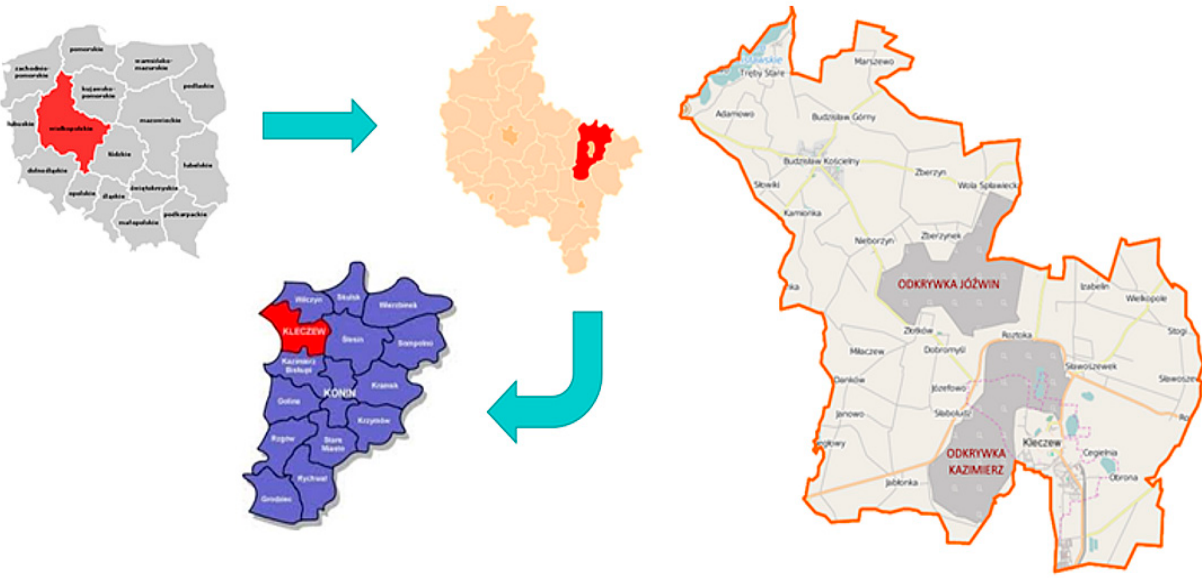
Figure 4. Location of the municipality of Kleczew in Poland ( left ) and exact location of the open-cast lignite mine in the municipality of Kleczew ( right ) [Source: own elaboration].